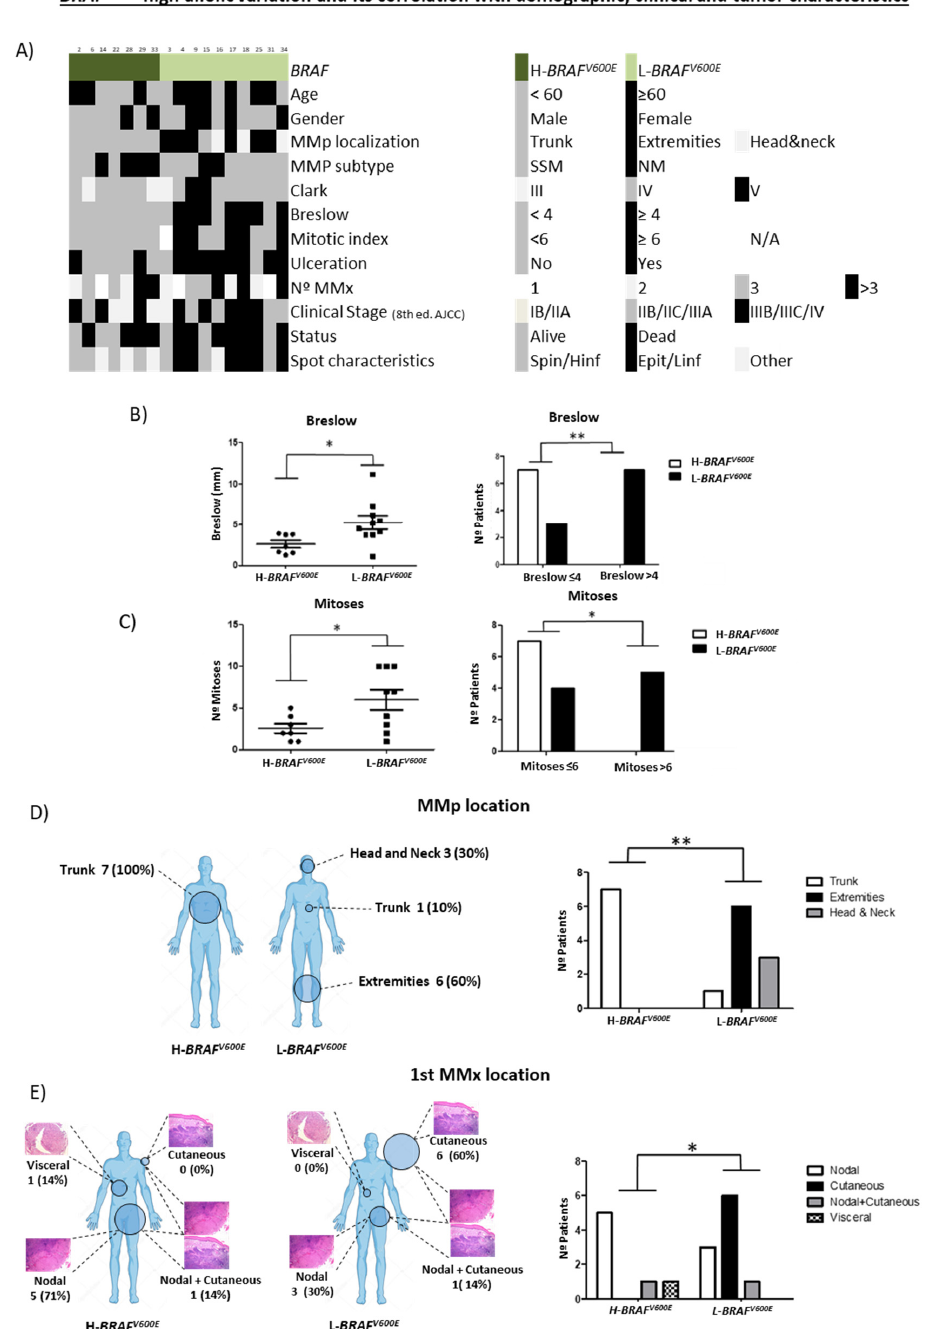
Figure 3. Clinicopathological characteristics of MMp depending on BRAF V600E MAF variation (high vs. low). ( A ) Heatmap showing demographic, clinical and tumor characteristics of MMp patients depending on BRAF V600E MAF variation. ( B ) Breslow thickness depending on BRAF V600E MAF variation and number of patients according to Breslow thickness (< 4 mm vs. ≥ 4 mm) in primary melanoma tumors. ( C ) Number of mitoses and number of patients according to mitotic index (<6 vs ≥ 6) depending on BRAF V600E MAF variation. ( D ) MMp and ( E ) first MMx location depending on H- BRAF V600E vs L- BRAF V600E patients. Statistical analysis was performed using t-test, Fischer exact tests (* p < 0.05; ** p < 0.01).